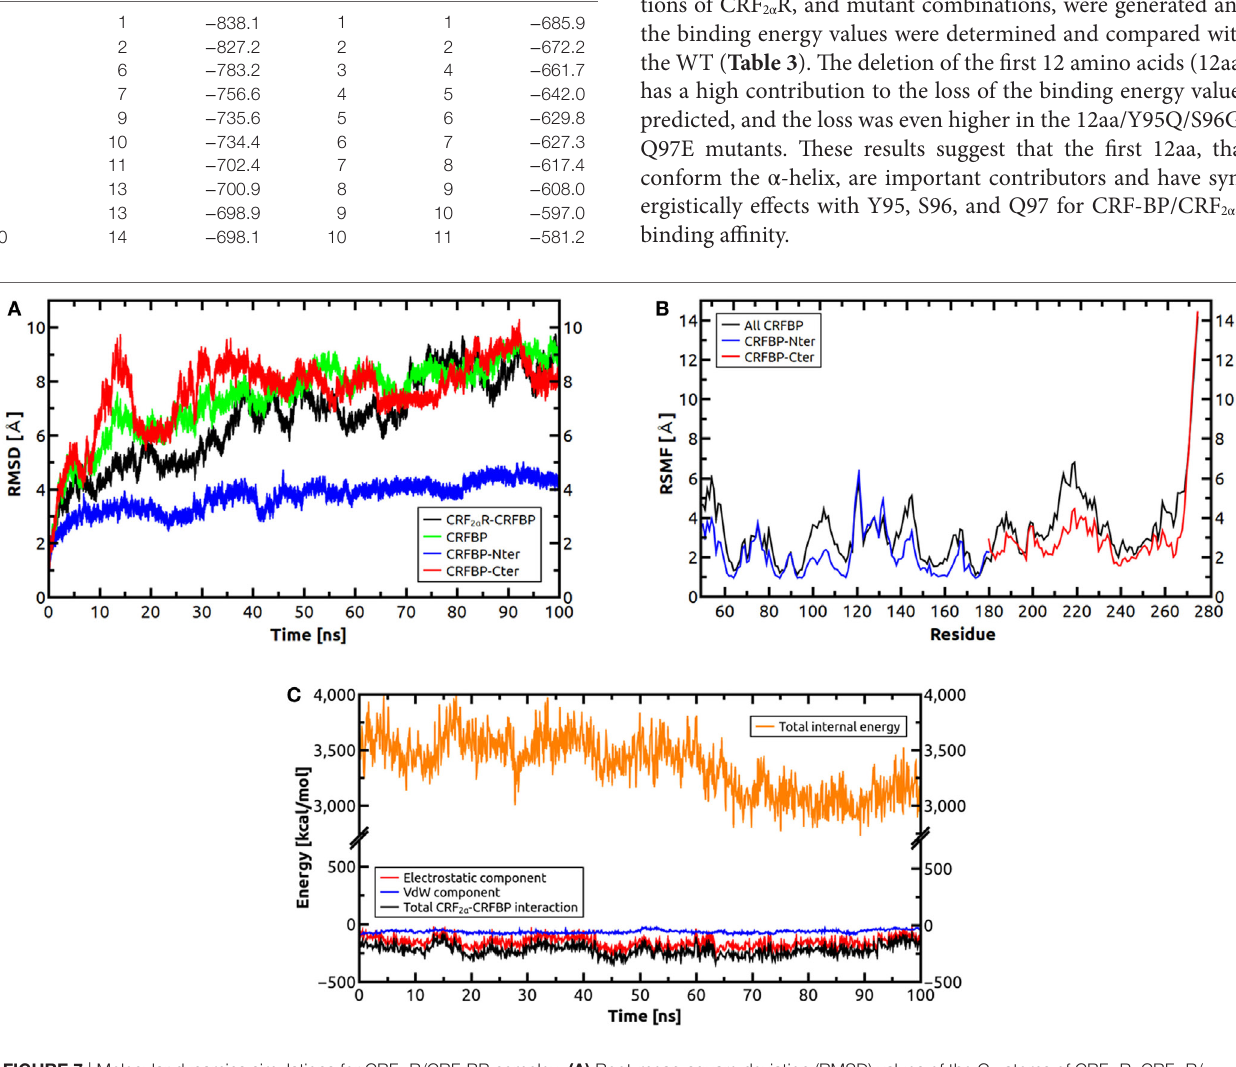
FigUre 7 | Molecular dynamics simulations for CRF 2 α R/CRF-BP complex. (a) Root-mean-square deviation (RMSD) values of the C α atoms of CRF 2 α R, CRF 2 α R/ CRF-BP, and CRF-BP N- and C-terminal domains. RMSD values of C α atoms of CRF 2 α R/CRF-BP (black line), CRF-BP only (green line), and CRF-BP N- and C-terminal domains (blue and red lines, respectively) are shown. (B) RMS fluctuation (RMSF) values of the C α atoms of CRF-BP. RMSF values for the N-term (blue lines), C-term (red lines), and full-length CRF-BP (black lines) are shown. (c) Interaction energy of the CRF 2 α R/CRF-BP